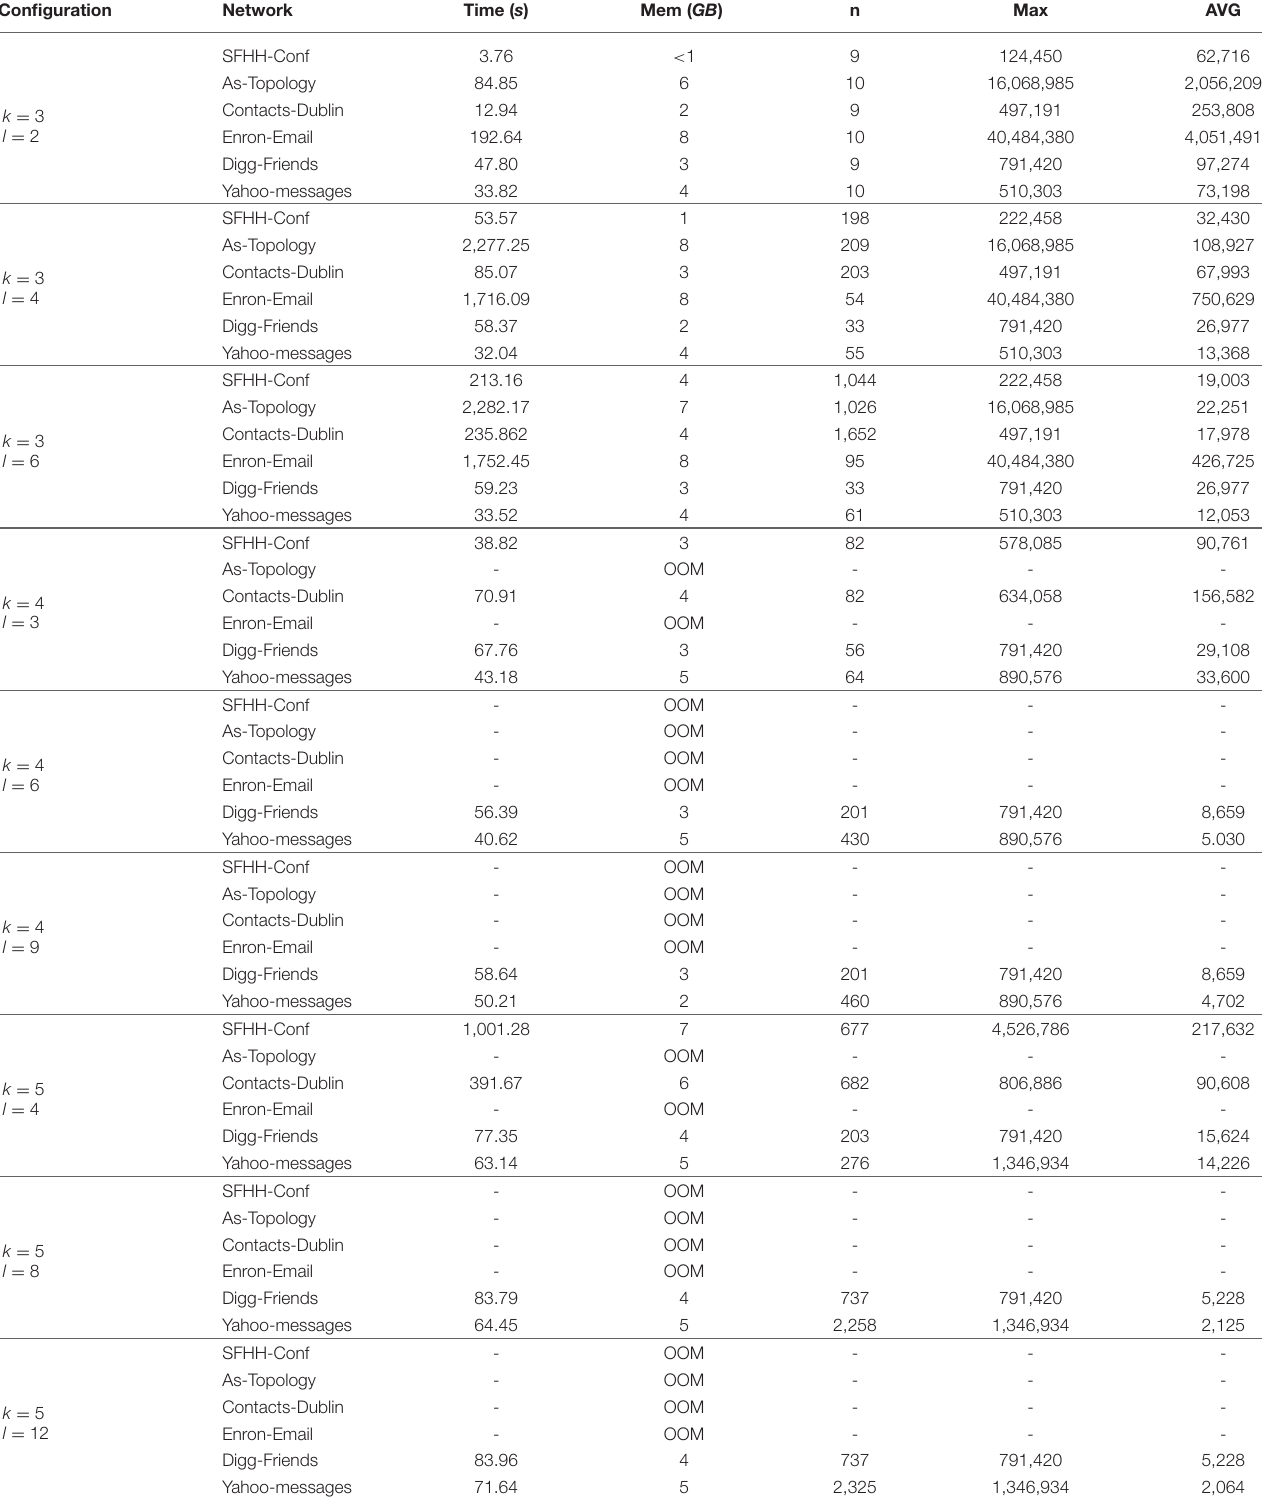
TABLE 4 | Experiments on Dataset 1 with 1 = 3 r and different combination of values of k and l .